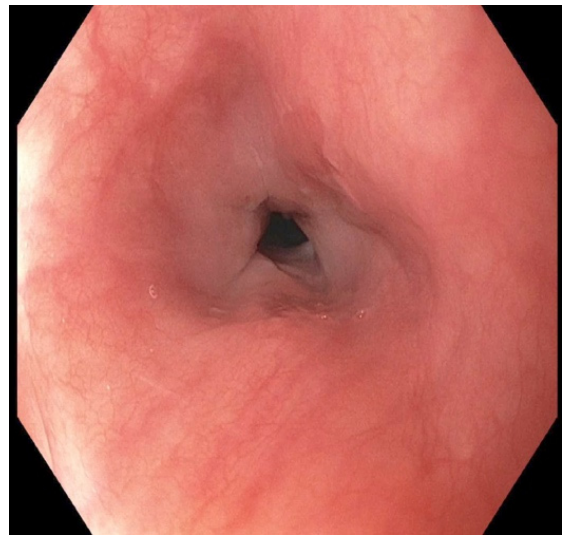
Figure 8. Endoscopy seven weeks following initial ingestion and removal of the button battery, showing esophageal stenosis that could not initially be traversed by the endo- scope.